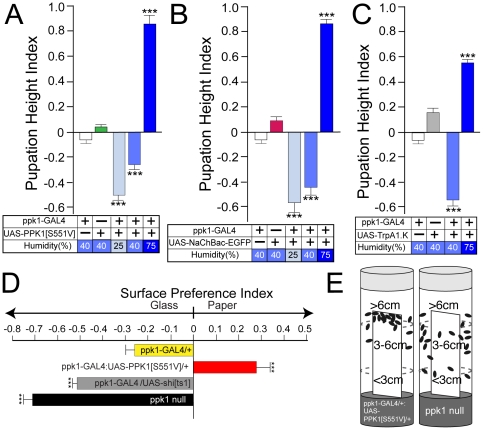
Hypersensitive aversion to dry surfaces caused by transgenic hyperactivation of mdIV nociceptor neurons.(A) Hyperactivation of mdIV nociceptors by transgenic expression of the constitutively-active PPK1[S551V] isoform resulted in a drastic decrease in pupation height depicted as a downward deflection of Pupation Height Index. This hypersensitive aversion behavior was completely suppressed by high external humidity(75%). (B) Hyperactivation of mdIV nociceptors by transgenic expression of the low-threshold voltage-gated Na channel UAS-NaChBac-EGFP caused a similar decrease in pupation height that was suppressed by high external humidity(75%). (C) Hyperactivation of mdIV nociceptors by transgenic expression of the heat-activated TrpA1.K channel caused the same significant decrease in overall pupation height that was suppressed by growth at high humidity(75%). All vials contained 50 larvae. (DE) Larval surface preference assay. (D) Third-instar larvae of the indicated genotypes were given a choice for pupation on the glass vial sides or on a strip of wetted Whatman filter paper inserted vertically at the center of the vial(see Materials and Methods). A preference index was calculated to indicate a preference for pupation on the moistened filter paper as a deflection to the right and a preference for the glass surface as a deflection to the left. Larvae with hyperactivated mdIV nociceptors expressing the constitutively-active PPK1[S551V] isoform showed a strong preference for pupation on the moist filter paper surface. Inactivation of mdIV nociceptors in ppk1GAL4/UAS-shi[ts1] and ppk1 null larvae caused an enhanced preference for pupation on the glass surface. (E) Schematic representation of the larval surface preference assay. Error bars represent SEM with n≥15 for all values. ***P<.0001, one-way ANOVA with Tukey posttest.